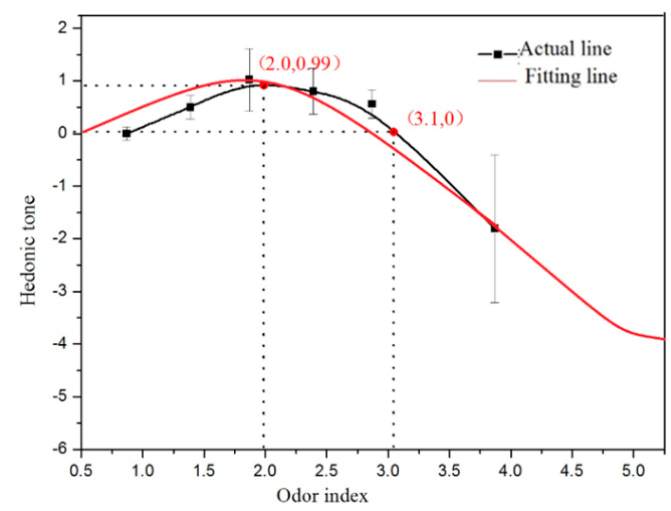
Figure 2. The behavior curve of limonene.